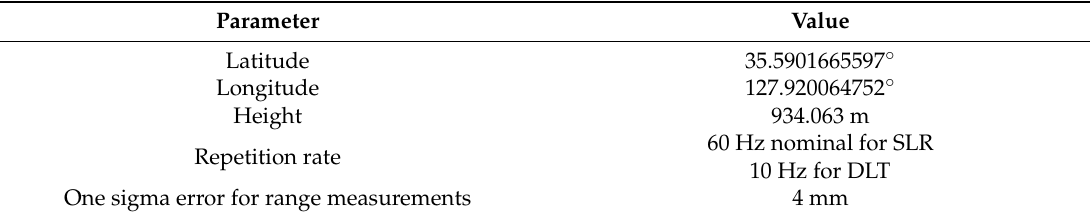
Table 2. Geochang station information. SLR—satellite laser ranging; DLT—debris laser tracking.